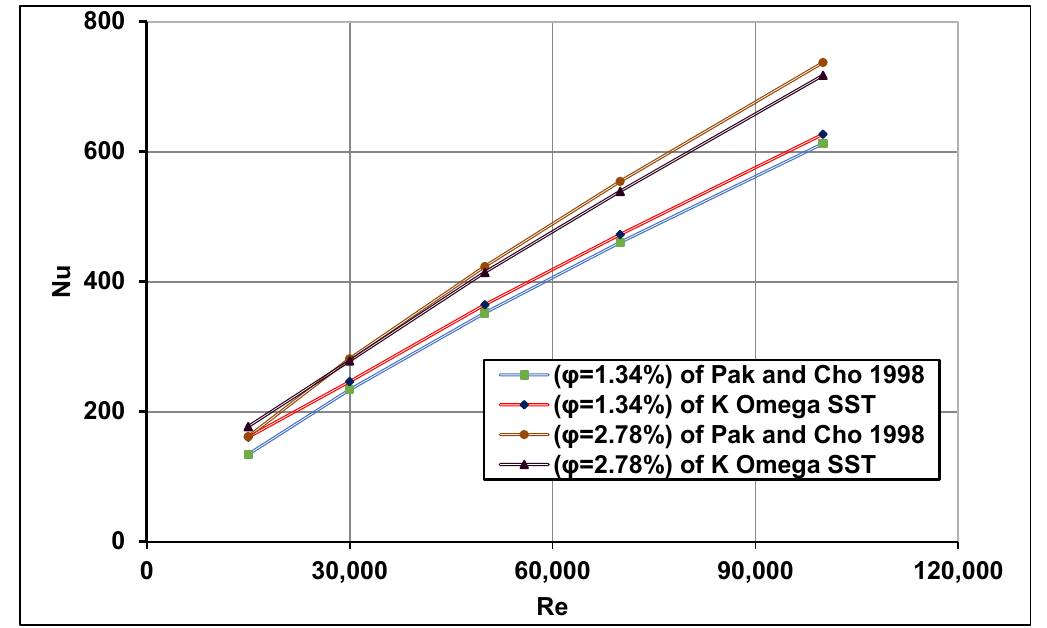
Figure 11. Computed average Nu number comparisons with measurements of Pak and Cho [49]. Based on all validations, it was concluded that the k − ω SST model performed better than the LS k − ε turbulence model. Thus, this turbulence model was utilized for all remaining numerical